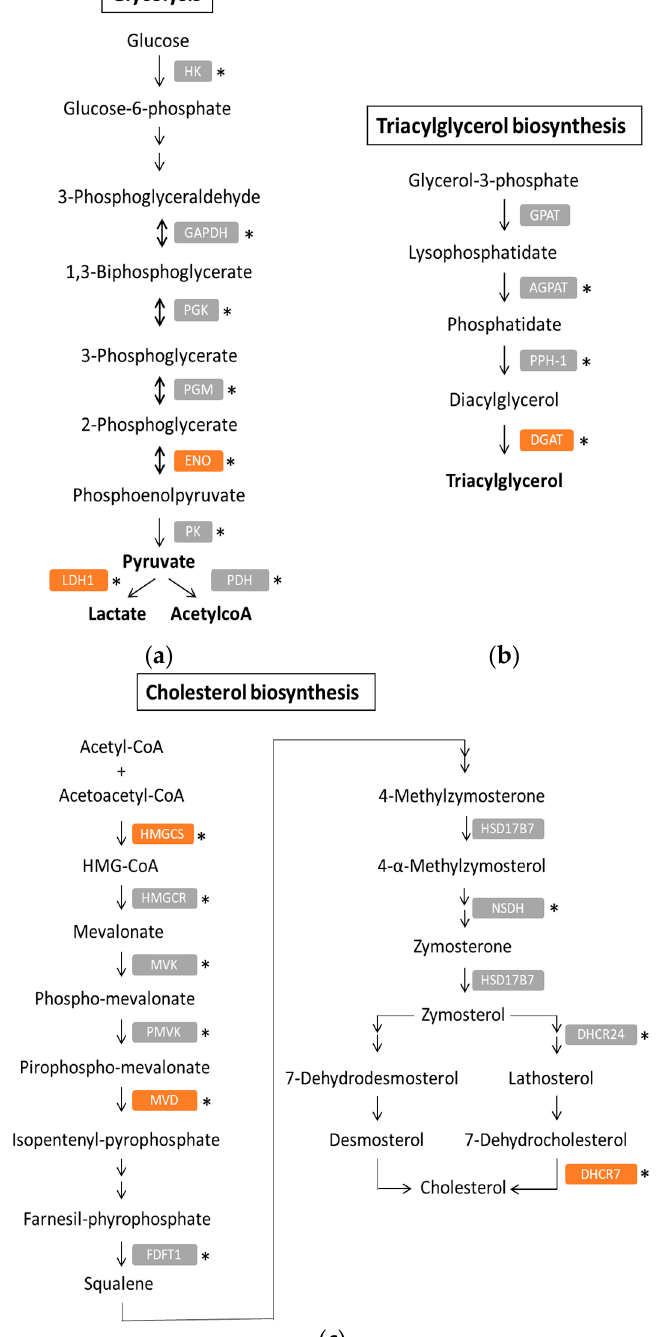
Figure 1. Genes from the glycolytic and lipogenic pathways up-regulated in PDAC samples. Expression of genes from glycolysis ( a ) triacylglycerol biosynthesis ( b ) and cholesterol biosynthesis ( c ) were analysed in cancerous ( n = 179) and non-cancerous ( n = 171) tissues (public gene expression information from PDAC vs. non-tumoural or normal pancreas tissues collected in the TCGA and GTEx databases) using GEPIA2 webtool (http://gepia2.cancer-pku.cn). The genes highlighted in the PDAC stratification studies from Daemen et al., Zhao et al. and Karasinska et al. are shown in orange. Significant differences in gene expression between cancerous and non-cancerous tissues was calculated by ANOVA test and is represented by an asterisk (* p ≤ 0.05).